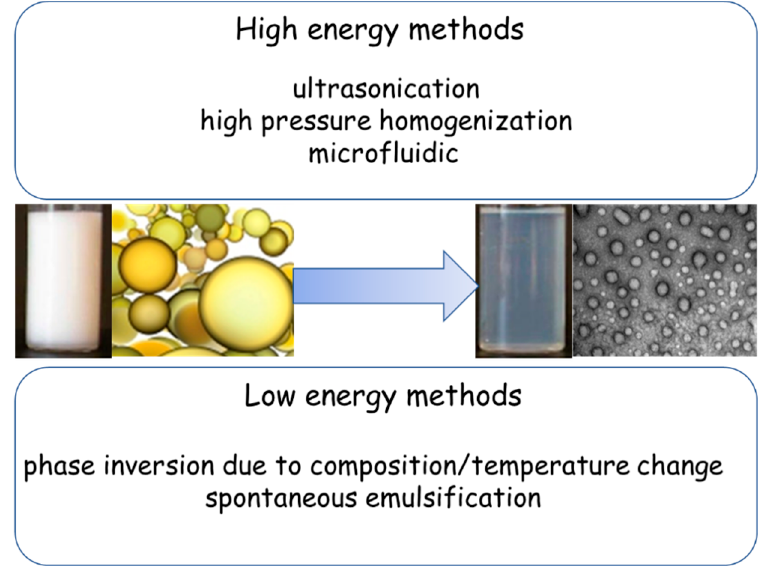
Figure 2. Preparation methods of nanoemulsions (NEs).